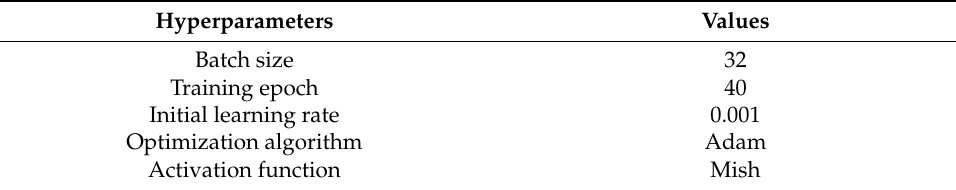
Table 4. Hyperparameter